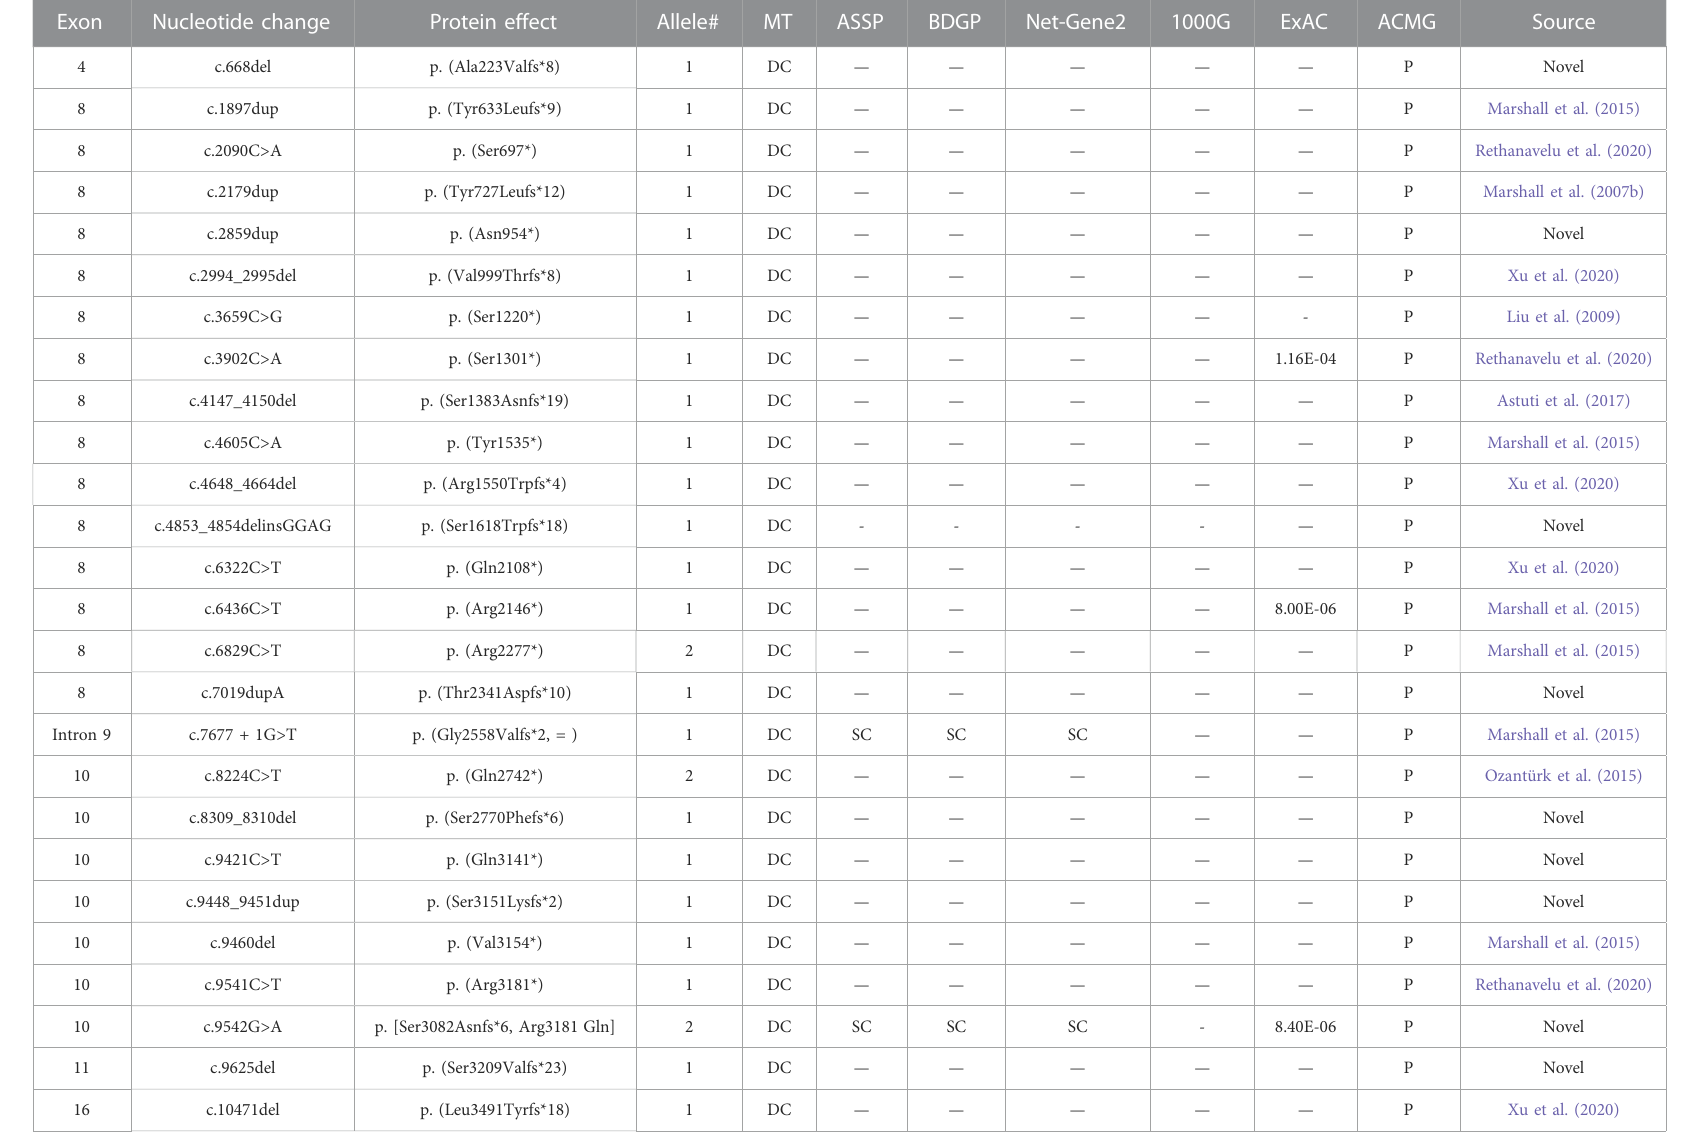
TABLE 1 Presumed pathogenic ALMS1 variants identi fi ed in this study and analysis of the variants by predictive